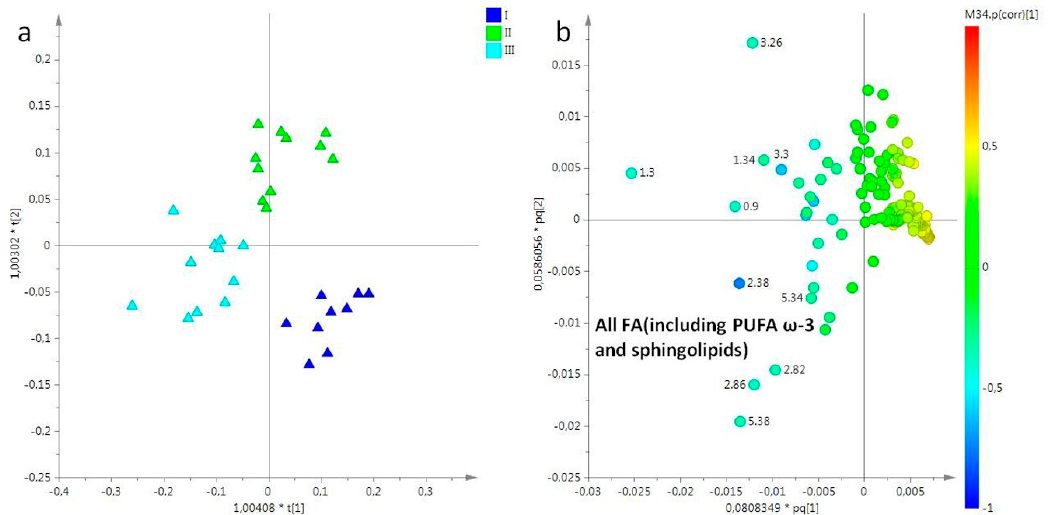
Figure 4. ( a ) OPLS-DA t[1] / t[2] scores plot of for lipid extracts of umbrella of R. pulmo collected in different sampling periods: blue triangle, March sampling (I); green triangle, May sampling (II); sky blue triangle, July sampling (III). ( b ) Loading plot for the model; the variables indicated ppm in the 1 H NMR spectrum.